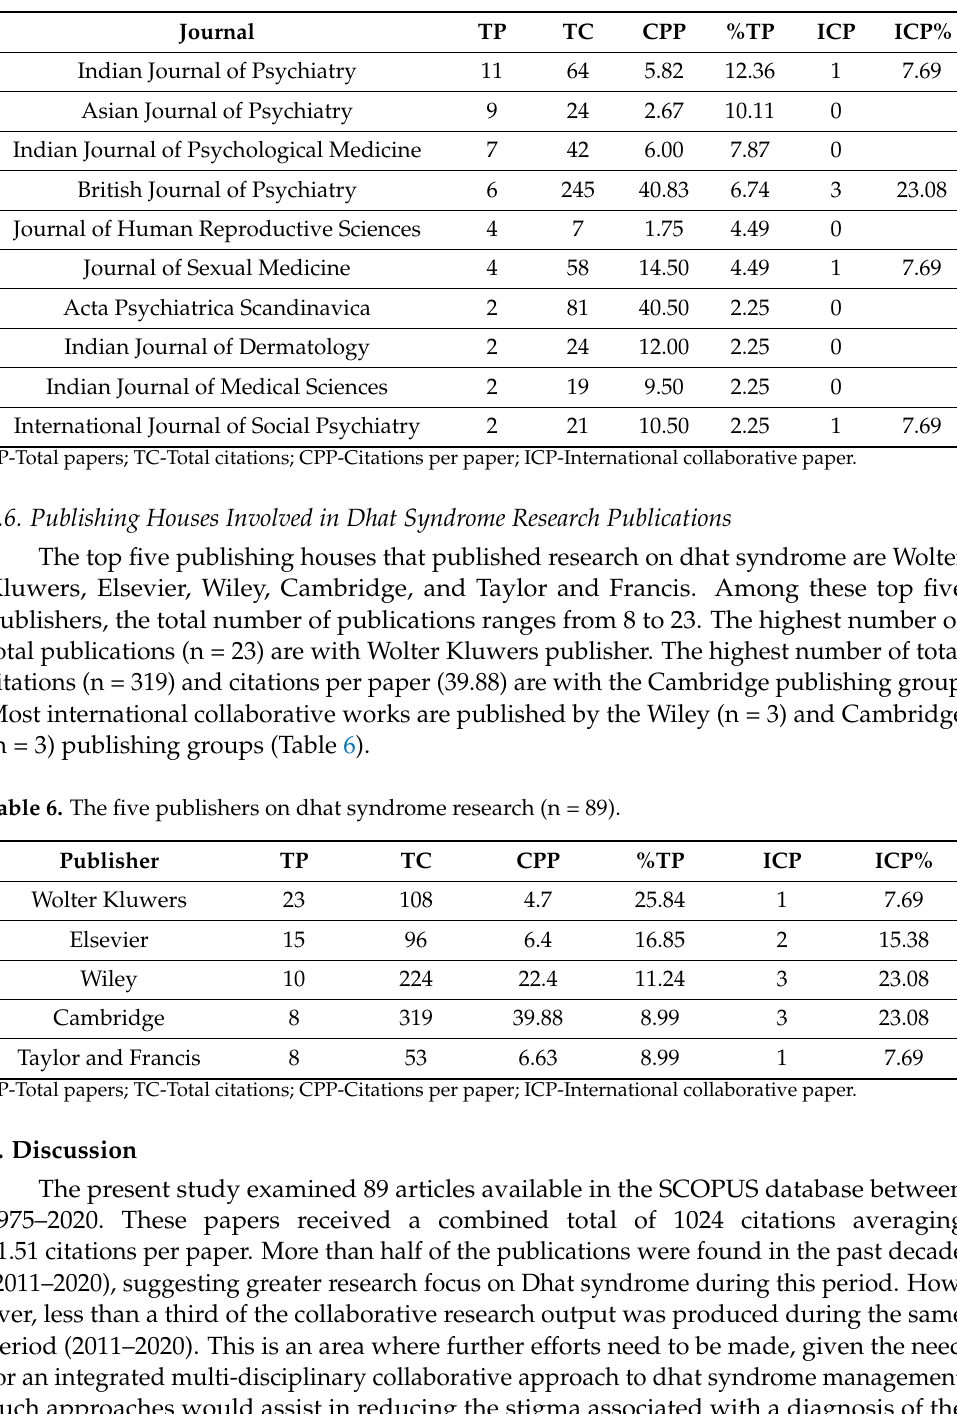
Table 5. The top ten journals on dhat syndrome (n = 89).